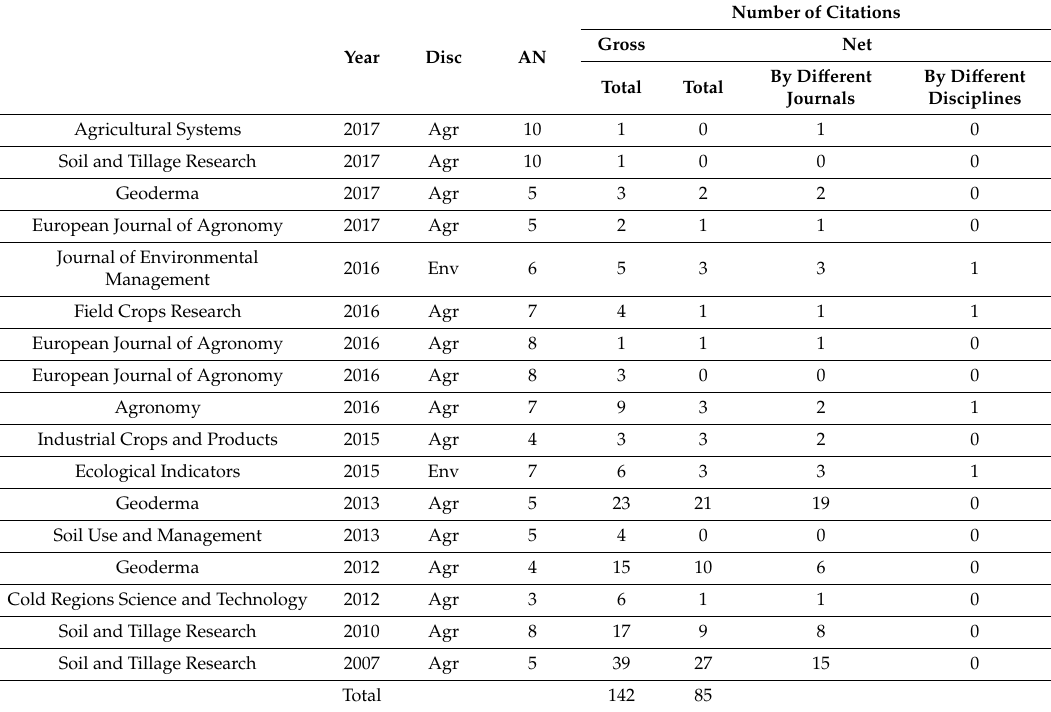
Table A5. Descriptive statistics and Scopus categories for the randomly selected PH analyzed for the life sciences. Each row represents a single publication; multiple publications in the same journal and same year are represented by separate rows.